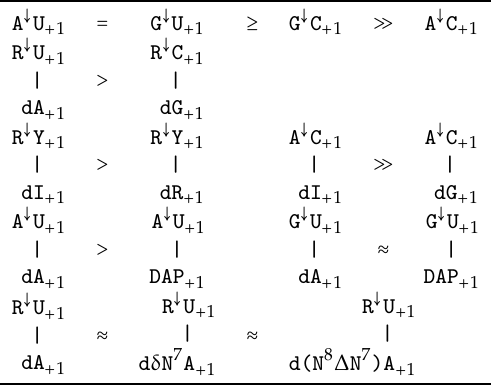
Table 1. Effect of nucleotide substitutions at position + 1 of the DNAzyme ( dN + 1 ) and the sequence of the nucleotides at the cleavage site of the RNA substrate (paired as well as unpaired N + 1 ) on the RNA cleavage rate. DAP + 1 , 2,6-diaminodeoxypurine; d δ N 7 A + 1 , 7-deazadeoxyadenine; d(N 8 ∆ N 7 )A + 1 , 8-aza-7-deazadeoxyadenine; for formulas see Figure